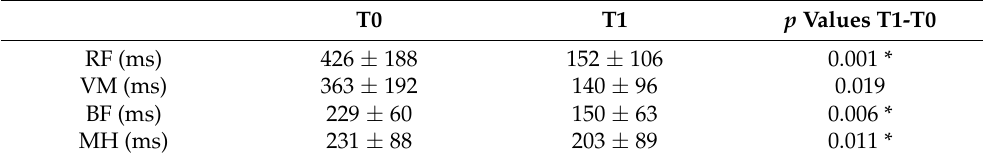
Table 1. Differences in pre-activation time (ms) of knee stabilizer muscles before COVID-19